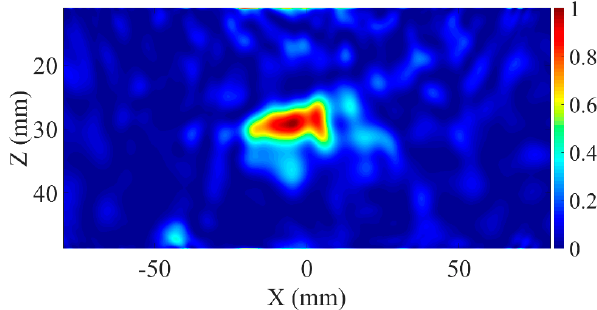
Figure 11. Reconstructed mm-wave image for Test 5 .